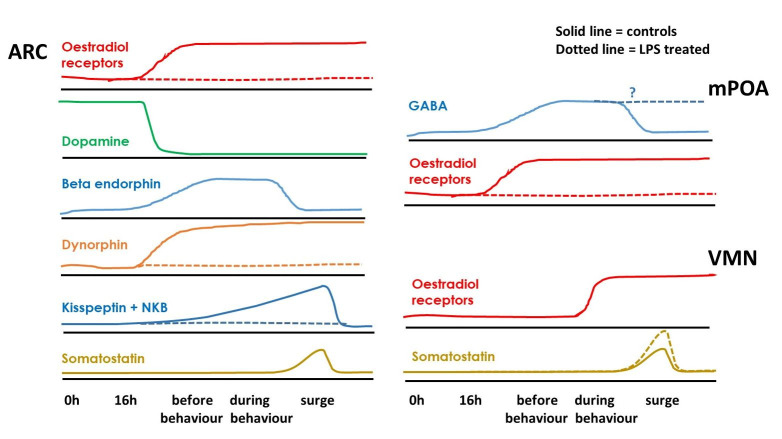
Diagram of neurotransmitter cell influence (i.e., % cells c-Fos activated) in the hypothalamic arcuate nucleus (ARC), medial pro-optic area (mPOA) and ventro-medial nucleus (VMN) at different times during follicular phase of intact ewes with (dotted line) or without treatment with lipopolysaccharide toxin (LPS) at 28 hours; LH surge occurs at 40 hours. No dotted line indicates no difference from controls. Adapted from Fergani et al. (2014b, 2017); and Robinson et al. (1991).